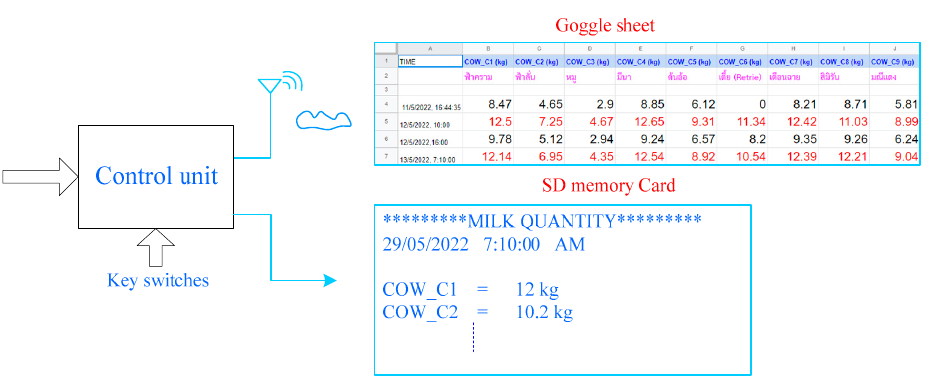
Figure 3. Proposed system.